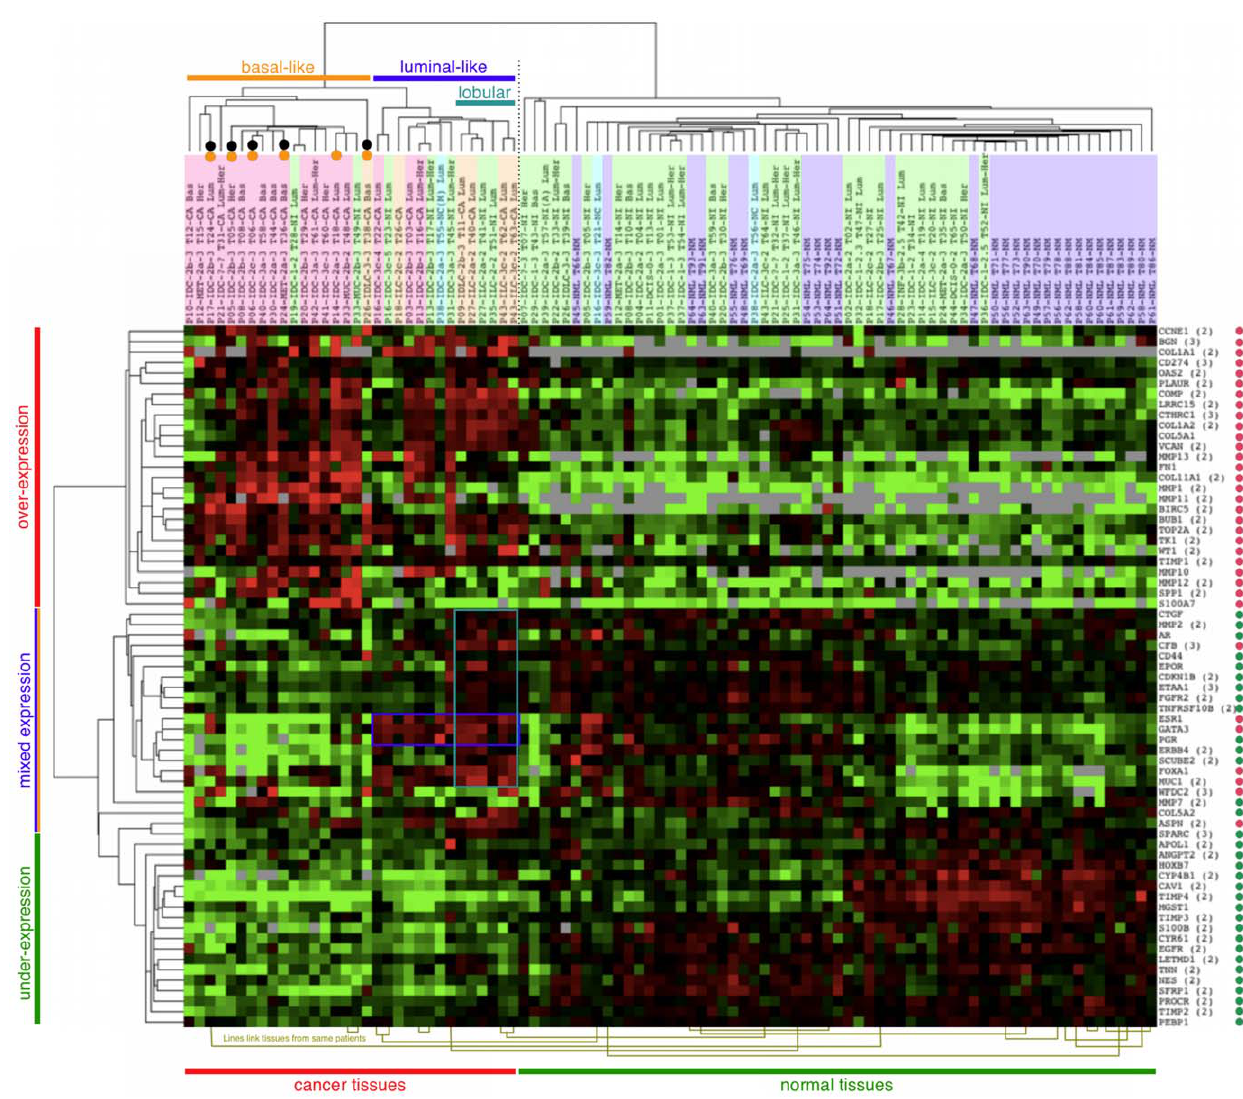
Figure 1. Unsupervised hierarchical clustering of 93 tissues and 67 genes. Unsupervised hierarchical clustering of 93 tissues (24 invasive cancers, 38 ipsilateral normal, 3 contralateral normal, 28 normal tissues from reduction mammaplasty) from 64 patients and 67 genes that discriminate between invasive tissues and mammaplasty normal tissues (red and green dots: over- and under-expression by PCR). Columns: tissues form two distinct clusters (indicated below the figure). Rows: genes form a cancer and a normal cluster, the latter being divided in one with under- expression in all cancer tissues (left, green line) and one with mixed expression (orange-blue line). Luminal-like and basal-like clusters are indicated above the figure. The part of the heat map driving the luminal-like cluster is boxed (blue: luminal-like genes, turquoise: lobular tissues). Tissues from deceased or recurred patients have a black or orange dot above the tissue descriptor which has the following abbreviated components: PatientNo – Diagnosis (IDC=invasive ductal carcinoma, ILC=invasive lobular carcinoma, MET=metaplastic carcinoma, MUC=mucinous carcinoma, NML=normal) – Stage – Grade TissueNo – Description (CA=cancer, NM=normal mammaplasty, NI=normal ipsilateral, NC=normal contralateral) BI-RADS Density Subtype (LUM=luminal, BAS=basal HER2). The tissue descriptors are shaded as follows: orange=lobular cancers, pink=other cancers, green=ipsilateral normals, blue=contralateral normals, purple=mammaplasty normals. Heat map: Red=up-regulation, green=down- regulation, grey=missing or zero value. The lines below the heat map connect tissues from the same